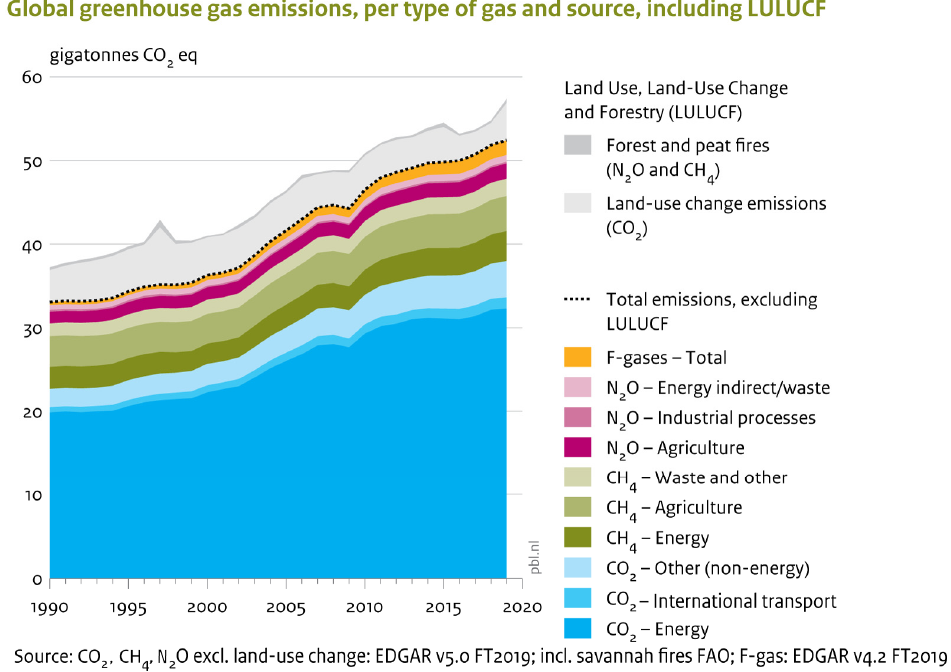
Figure 2. Emissions of global greenhouse gases based on the type and source of gas. Reprinted with permission from reference [11].